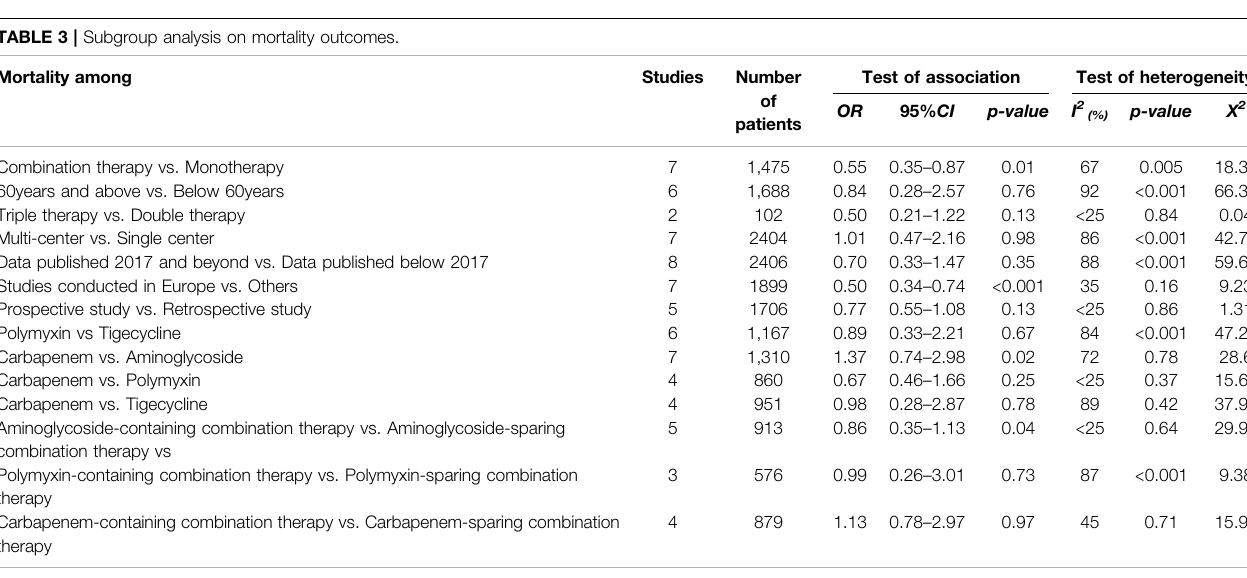
TABLE 3 | Subgroup analysis on mortality